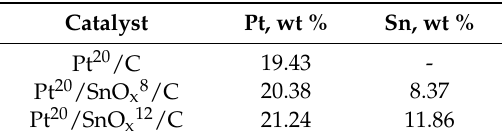
Table 1. EDS elemental content data.